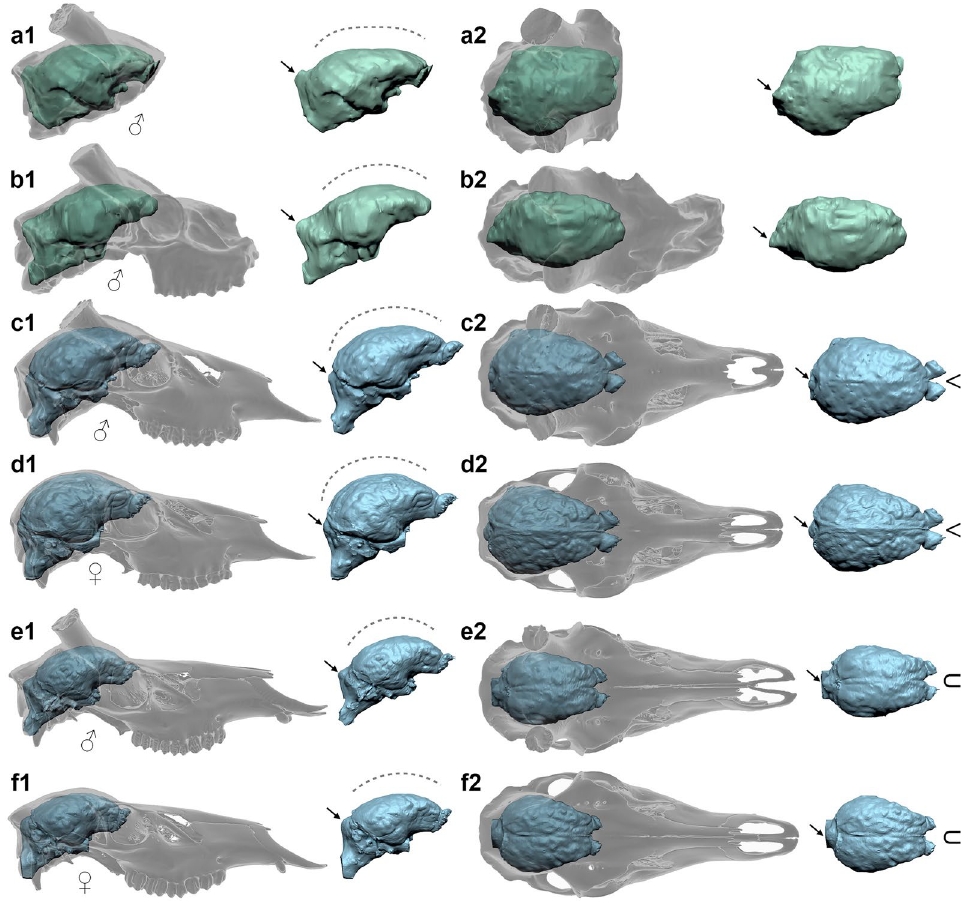
Figure 3. CT-based comparison of crania and digital brain endocasts. ( a ) ‘Pseudodama’ nestii SABAP_UMB 337643; ( b ) SABAP_UMB 337655; ( c,d ) extant Dama dama , male CZUFLD FaD002 ( c ) and female CZUFLD FaD003 ( d ); ( e,f ) extant Cervus elaphus , male CZUFLD ReD002 ( e ) and female CZUFLD ReD003 ( f ). Crania and digital models in right lateral ( a1–f1 ) and dorsal ( a2–f2 ) views. The black arrows indicate the prominence of the cerebellum, while symbols on the right indicate the V or U shape of the olfactory bulbs. All the images are